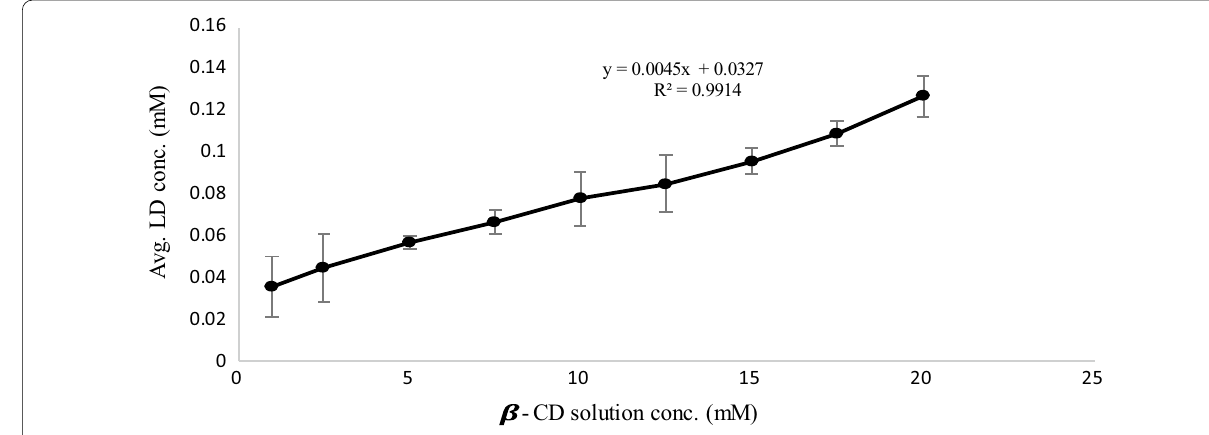
Fig. 1 Phase solubility study of LD in presence of different concentrations (1–20 mM) of β-CD